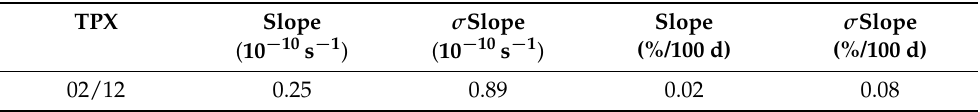
Table 20. Slope of time history of the luminosity ratio measured by TPX02 and TPX12 averaged over the data recorded by layers 1 and 2. The slope values and the uncertainties are given per second and in percent per 100 days. Taken from Ref.